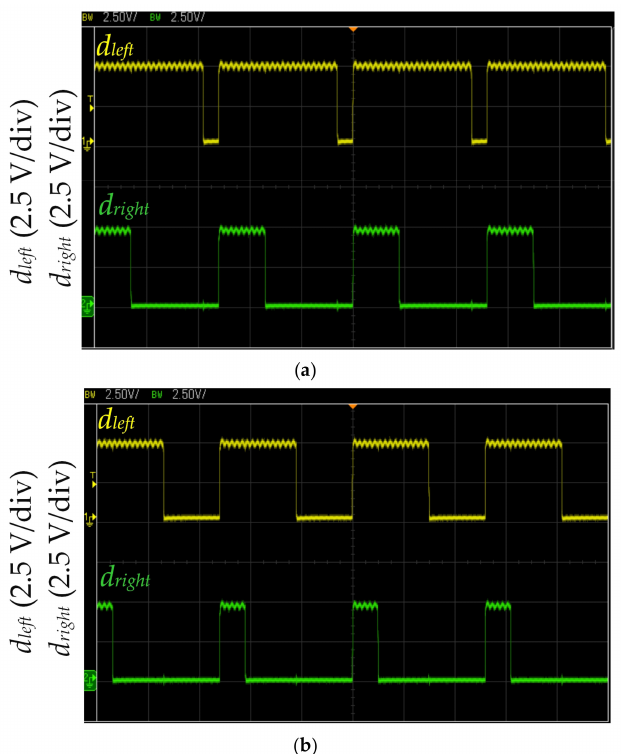
Figure 14. MCU output d left and d right waveforms during right turning: ( a ) with proposed LCOT control strategy and ( b ) with fixed duty cycle method. (The horizontal axis: 2 µ s.)